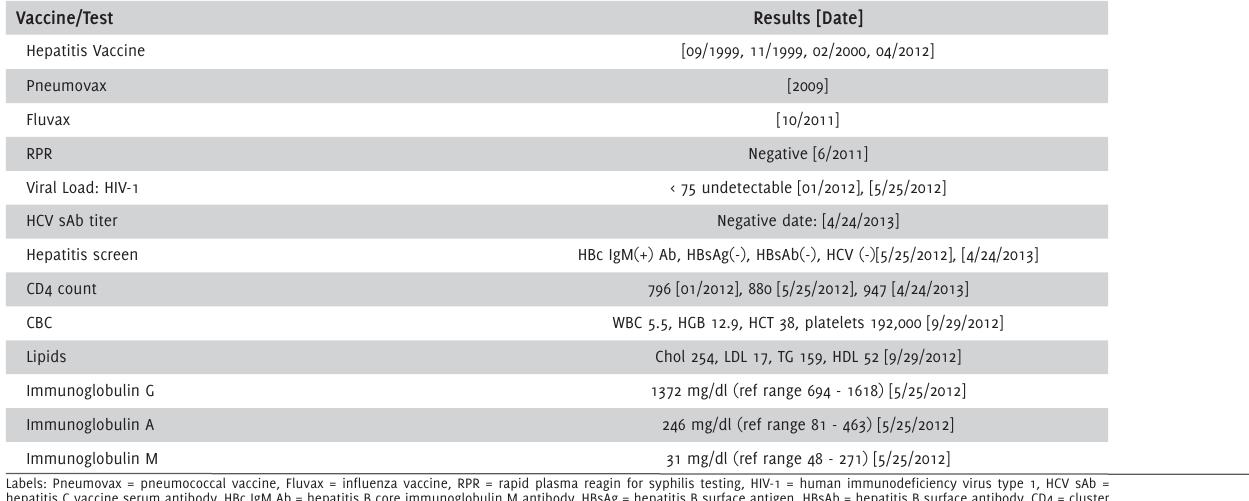
Labels: Pneumovax = pneumococcal vaccine, Fluvax = influenza vaccine, RPR = rapid plasma reagin for syphilis testing, HIV-1 = human immunodeficiency virus type 1, HCV sAb = hepatitis C vaccine serum antibody, HBc IgM Ab = hepatitis B core immunoglobulin M antibody, HBsAg = hepatitis B surface antigen, HBsAb = hepatitis B surface antibody, CD4 = cluster of differentiation 4, CBC = complete blood count, WBC = white blood cells, HGB = hemoglobin, HCT = hematocrit, Chol = cholesterol, LDL = low-density lipoprotein, TG = triglycerides, HDL = high-density lipoprotein.